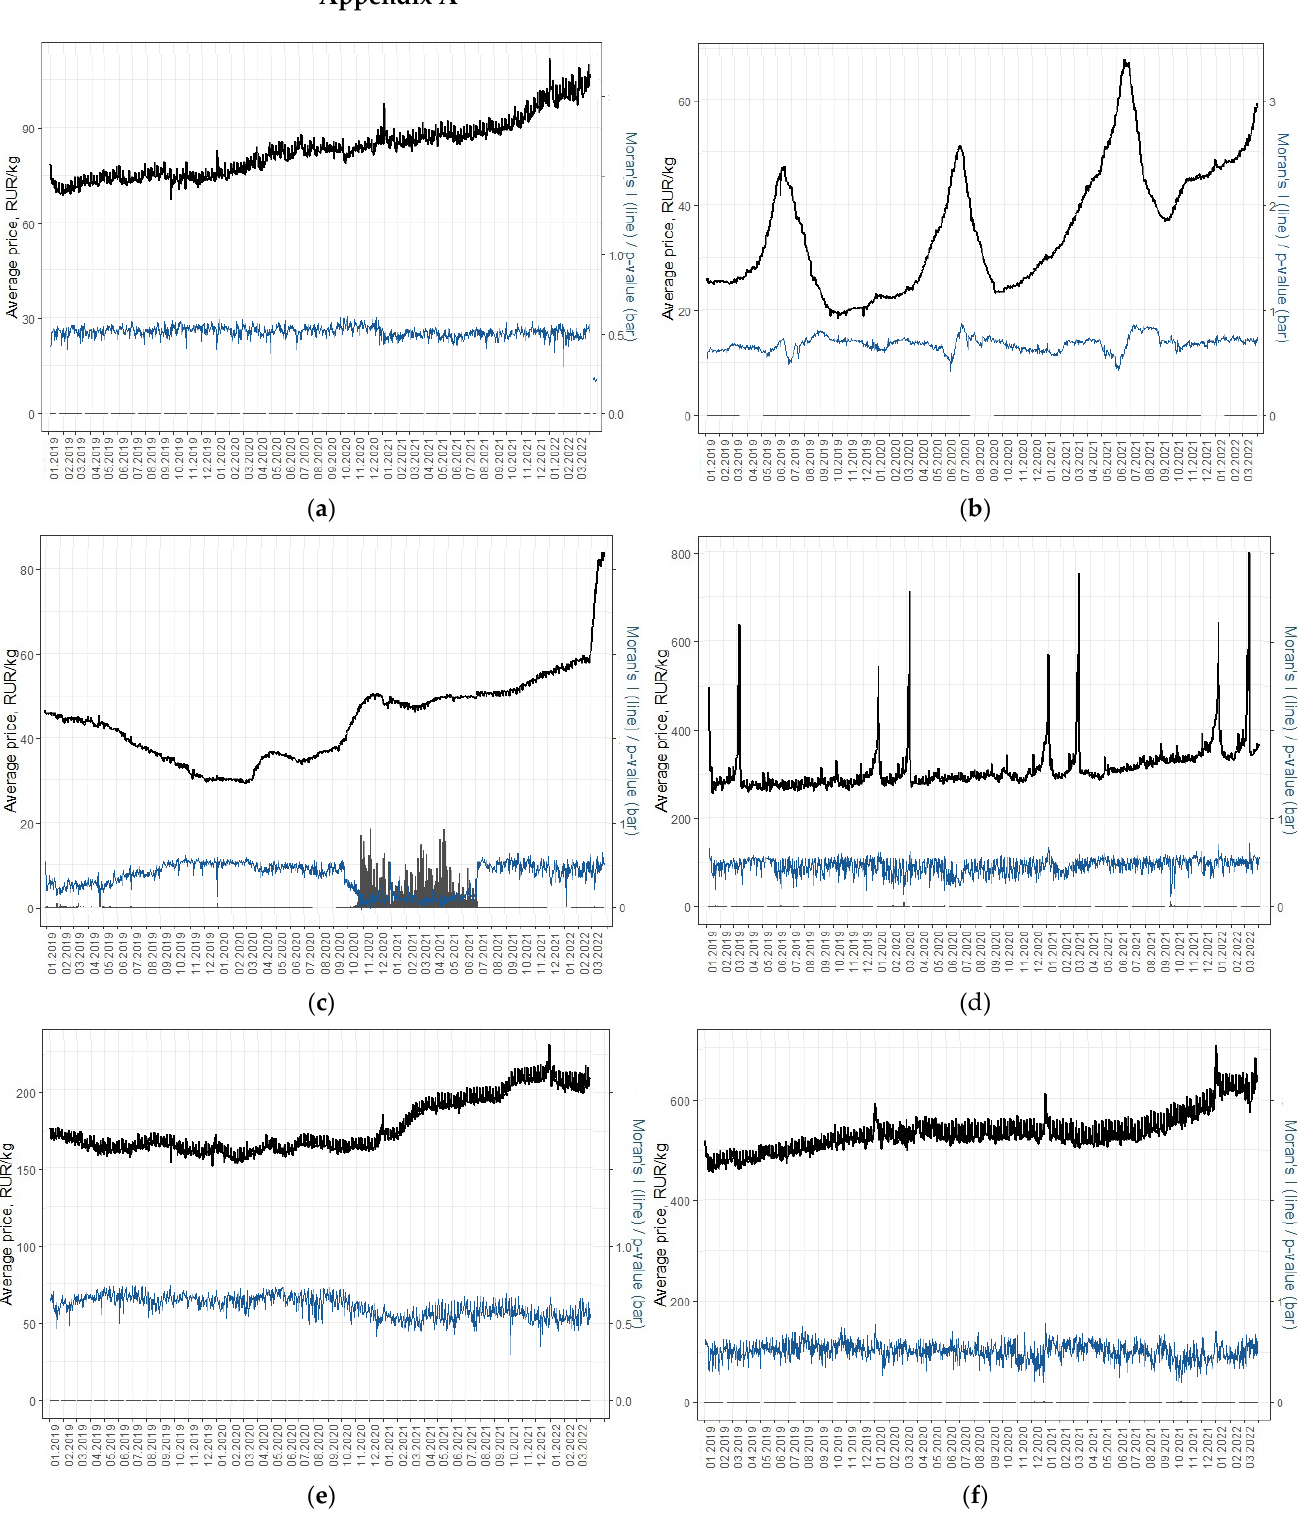
Figure A1. Daily average regional price of Pasta ( a ), Potatoes ( b ), Sugar ( c ), Candies ( d ), Poultry meat ( e ), Butter ( f ) and global Moran’s I id index (based on inverse distance weights matrix), from 1 January 2019 to 31 March 2022.